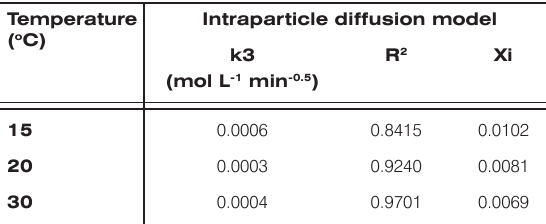
Table 5. Isotherms and their linear form Isotherm Linear form